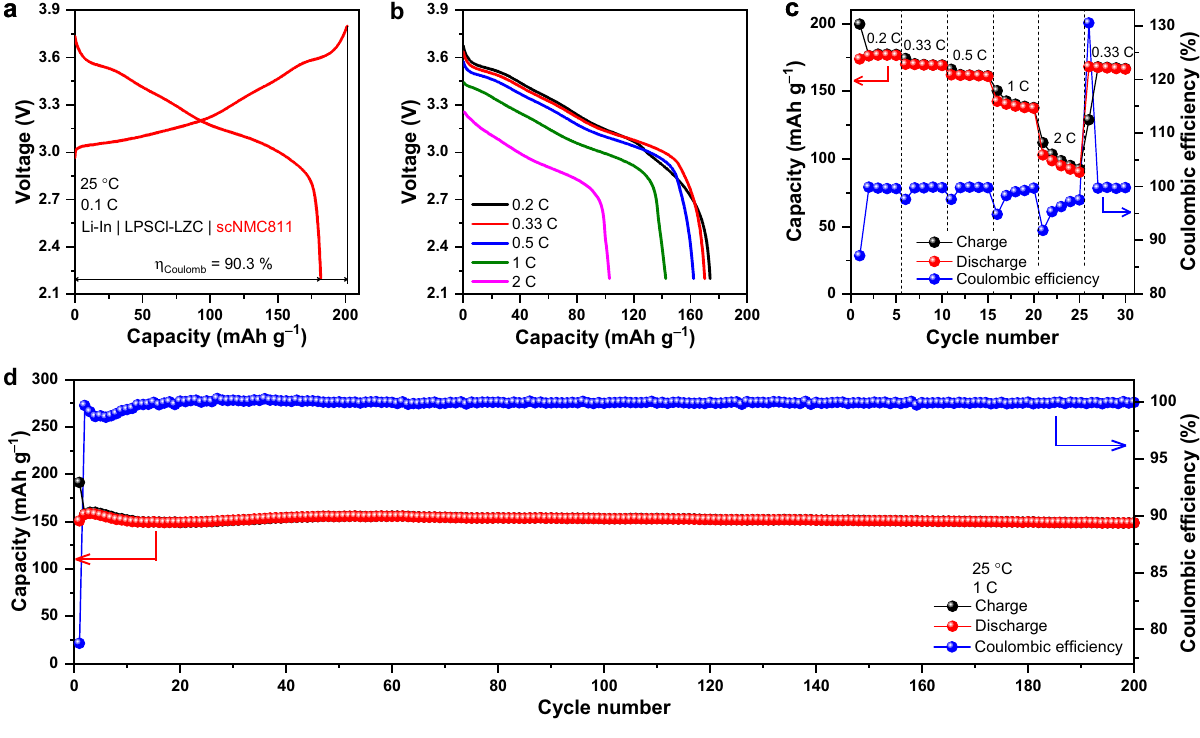
Fig. 6 Electrochemical performance of the Li-In | LPSCl-LZC| scNMC811 cell. a The initial charge/discharge curves at 0.1 C, with the Coulombic ef fi ciency η Coulomb denoted. b , c Rate capability at 0.2, 0.33, 0.5, 1 and 2 C. d Long-term cycling performance at 1